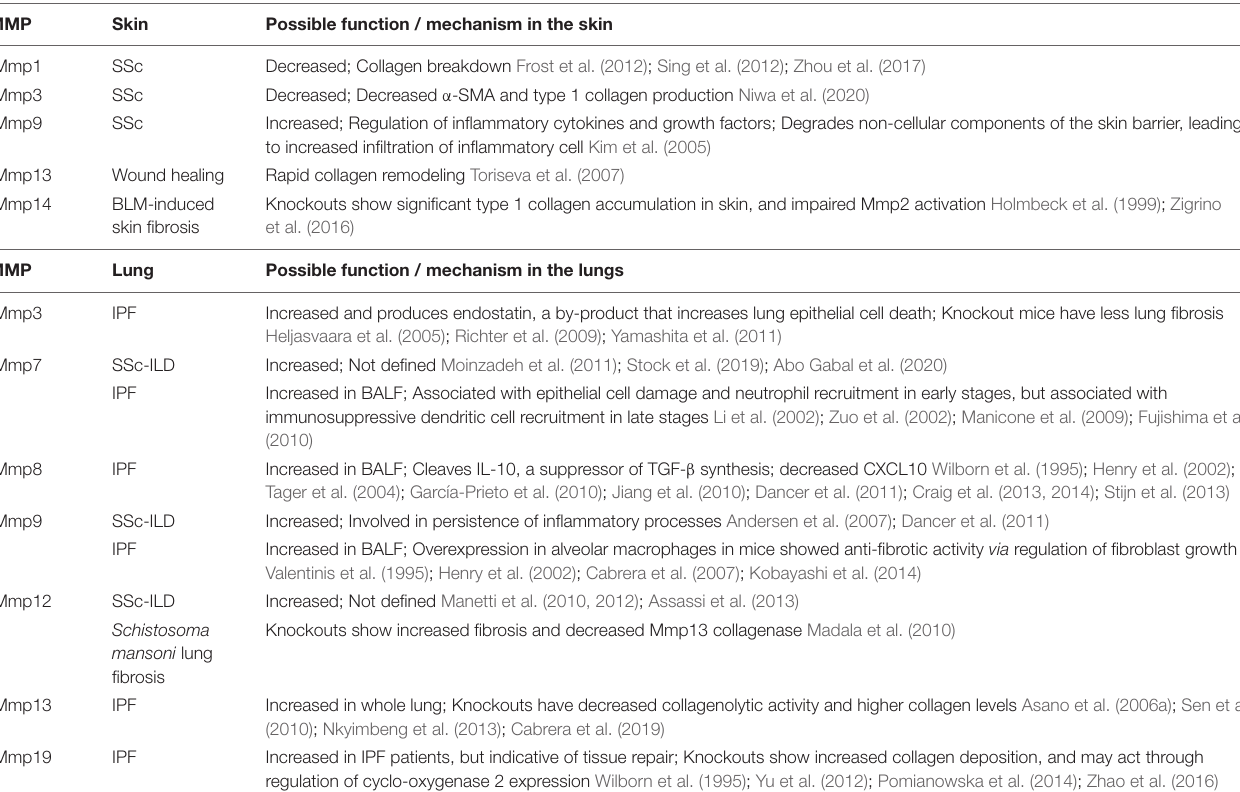
TABLE 1 | Summary table of selected MMPs with therapeutic potential for targeting in SSc skin and lungs to improve fibrosis and ECM